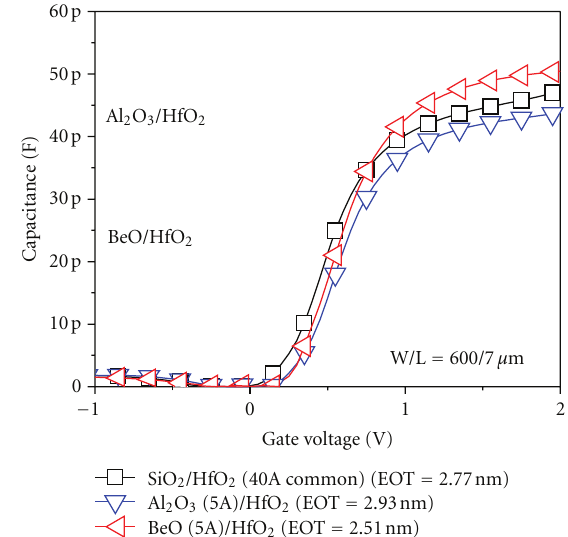
Figure 6: Stress-induced leakage current ( Δ J g / J 0 ) versus stress time. E e ff = ( V g − V fb )/EOT.